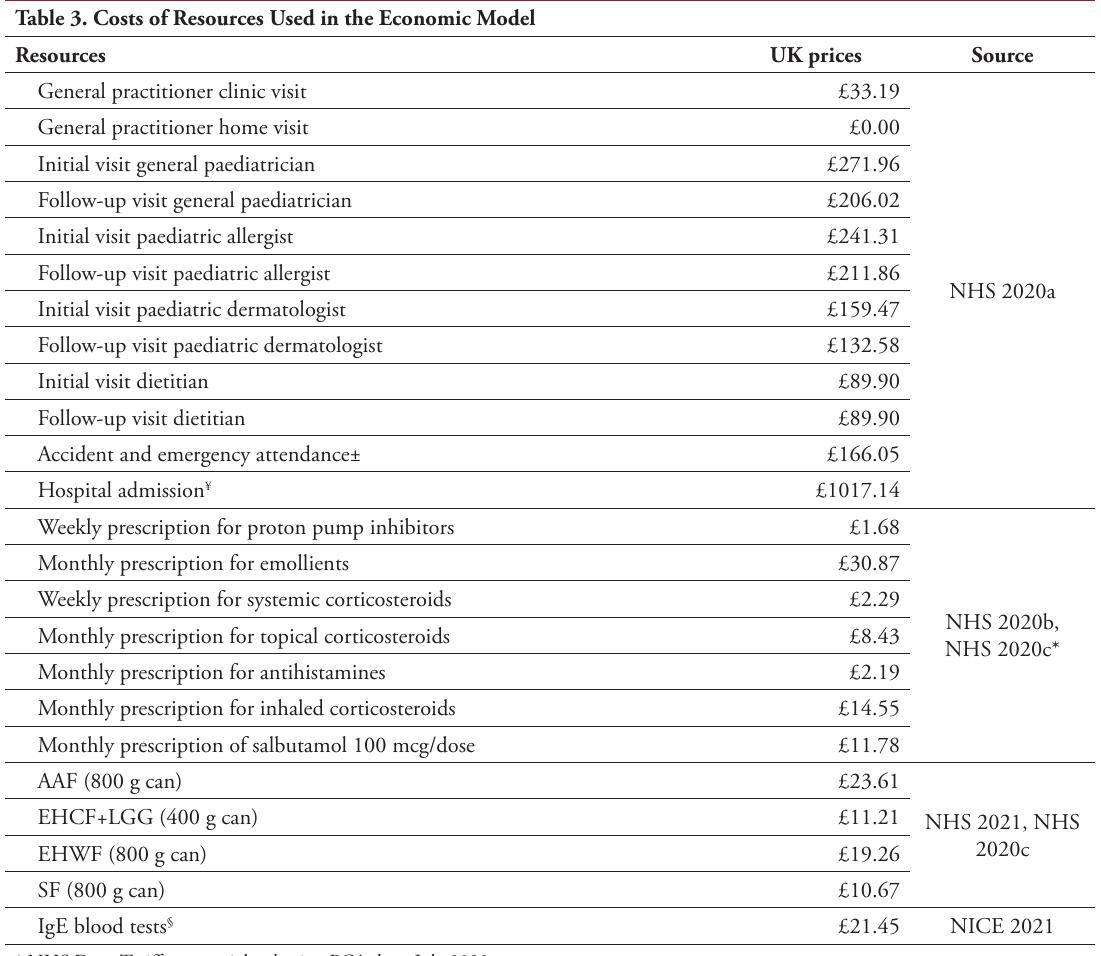
Table 3. Costs of Resources Used in the Economic Model Resources